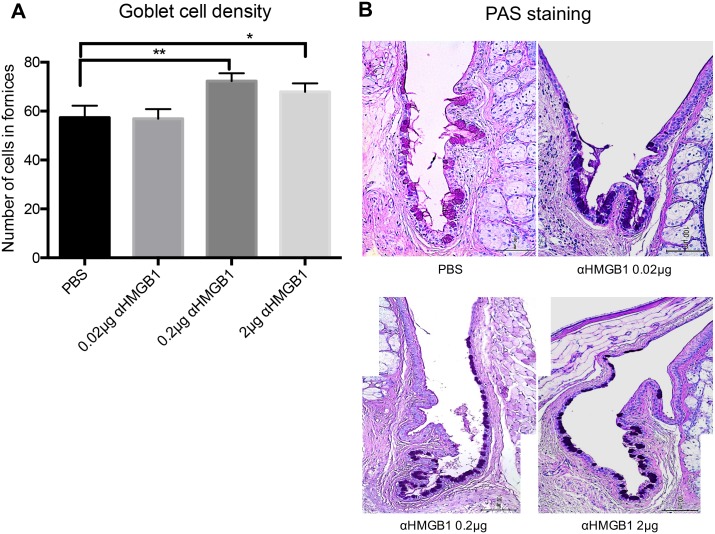
Goblet cell density in NOD.B10.H2b mice conjunctiva after anti-HMGB1 treatment.(A) Increased goblet cell density in 0.2 μg anti-HMGB1- and 2 μg anti-HMGB1-treated mice (Mann-Whitney test, ** p = 0.0066, *p = 0.057; marginal significance). (B) Representative images of PAS staining of the forniceal conjunctiva (x200). Data are presented as mean ± standard error. Scale bar indicates 100 μm.